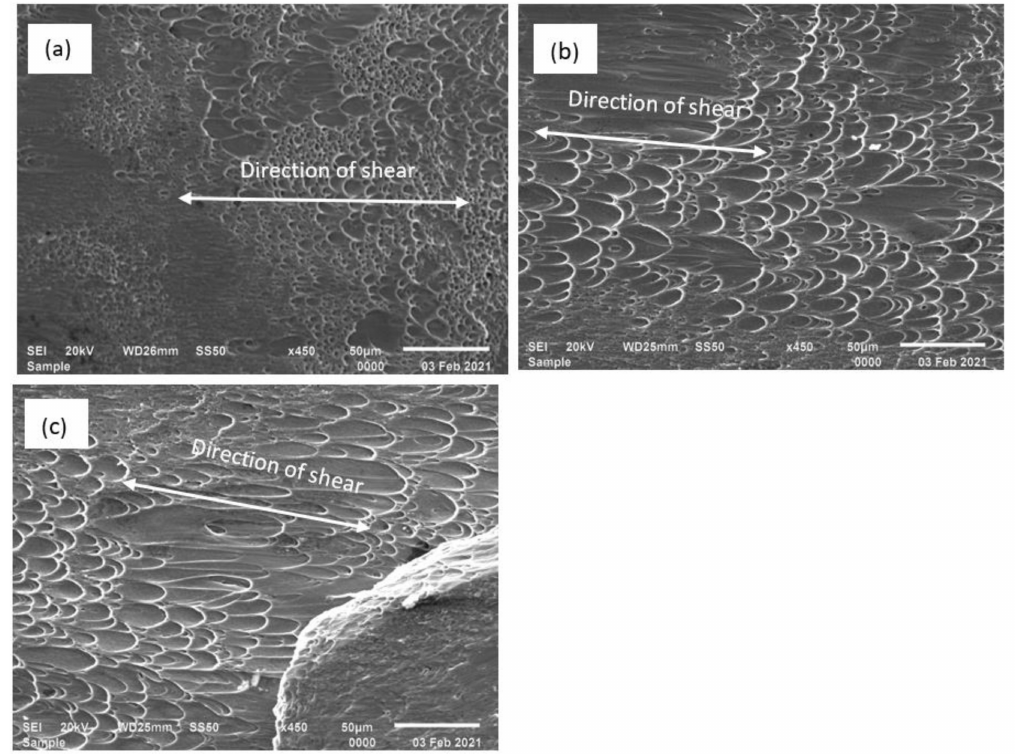
Figure 21. Typical characteristic features on the fracture surfaces of samples D at temperatures of ( a ) 25 ◦ C, ( b ) 200 ◦ C, and ( c ) 500 ◦ C at a magnification of